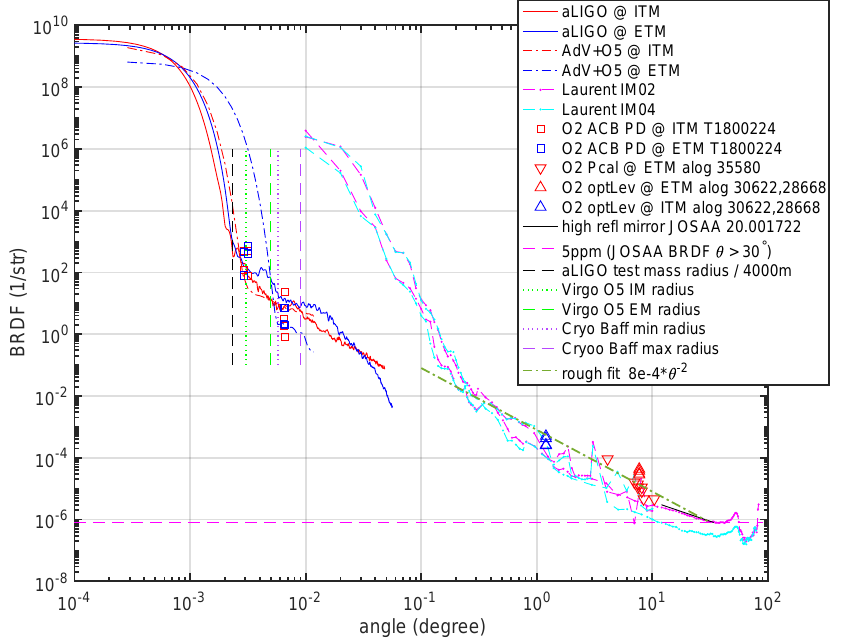
Figure 6. BRDF of the main test masses. The BRDF for scattering angles between 10 − 4 and 10 − 3 degrees can be obtained from the real surface maps of the mirrors. Information on the Virgo and LIGO surface maps is provided in Refs. [14] and [17], respectively. The values corresponding to scattering angles of about 10 − 2 degrees are obtained from measurements conducted by baffle photodiodes in LIGO. The BRDF at scattering angles around 10 degrees is obtained by measurements with integrating spheres, viewports, etc. The pink and blue dashed lines (labelled as “Laurent IM02” and “Laurent IM04”, respectively) were measured with a small laser beam with low power, 6.88 · 10 − 3 W, and sample spot diameter of 2